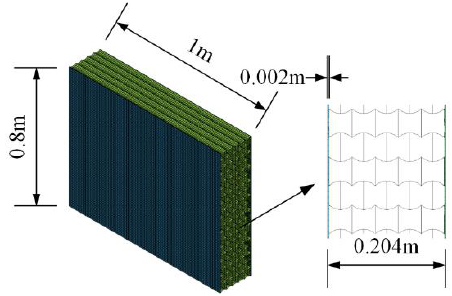
Figure 3. Sandwich blast wall dimensions.